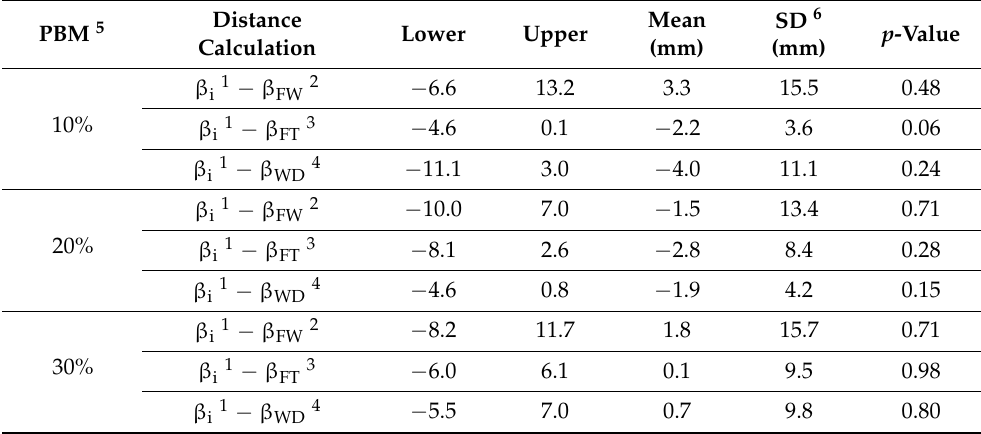
Table 3. Calculated differences of angle β , indicating internal rotation of the tibia, for each load and surgical